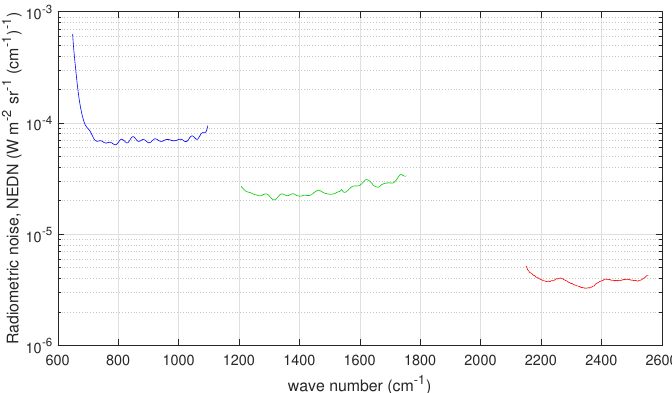
Figure 3. CrIS radiometric noise in units of NEDN (W-m − 2 sr − 1 (cm − 1 ) − 1 ) for the three bands of the instrument.